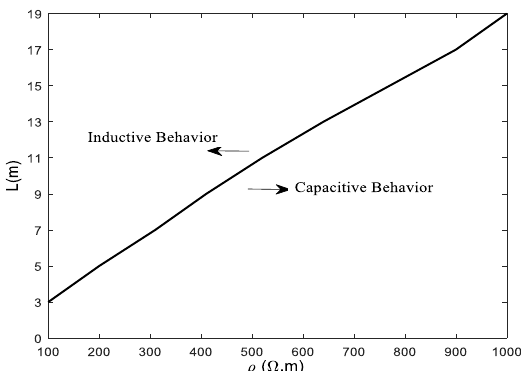
Figure 9: Inductive and capacitive behavior of vertical grounding rod as a function of the length and soil